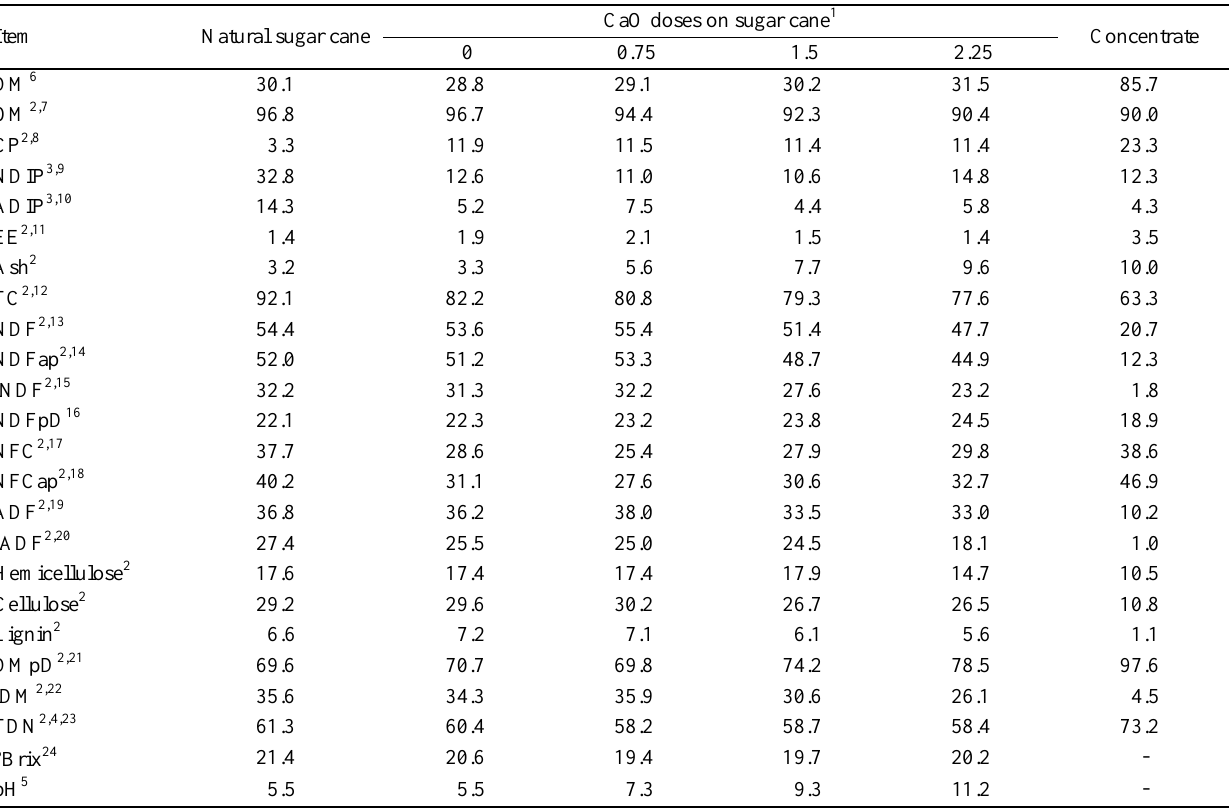
Table 2. Average contents of dry matter, nutrients and pH values in the cane sugar in nature, cane sugar treated with different doses of calcium oxide (CaO), and concentrated Item